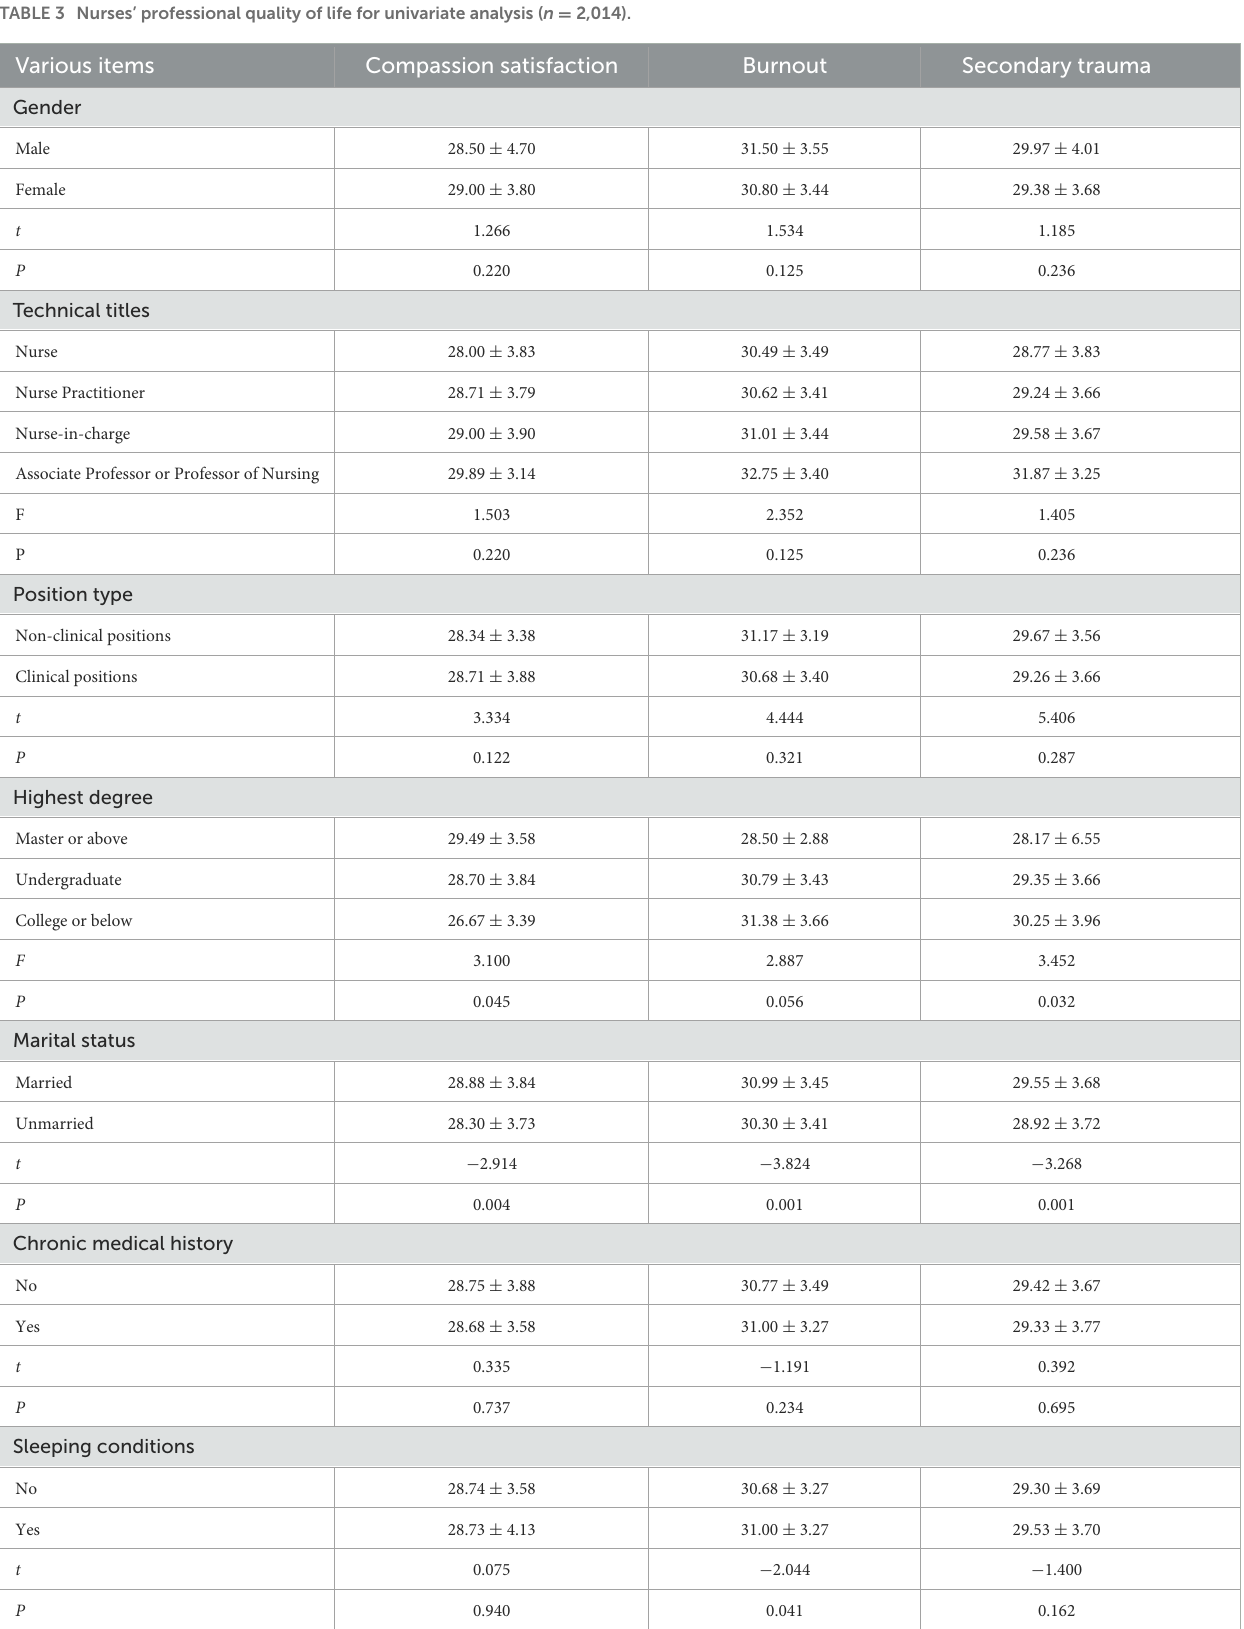
TABLE 3 Nurses’ professional quality of life for univariate analysis ( n =